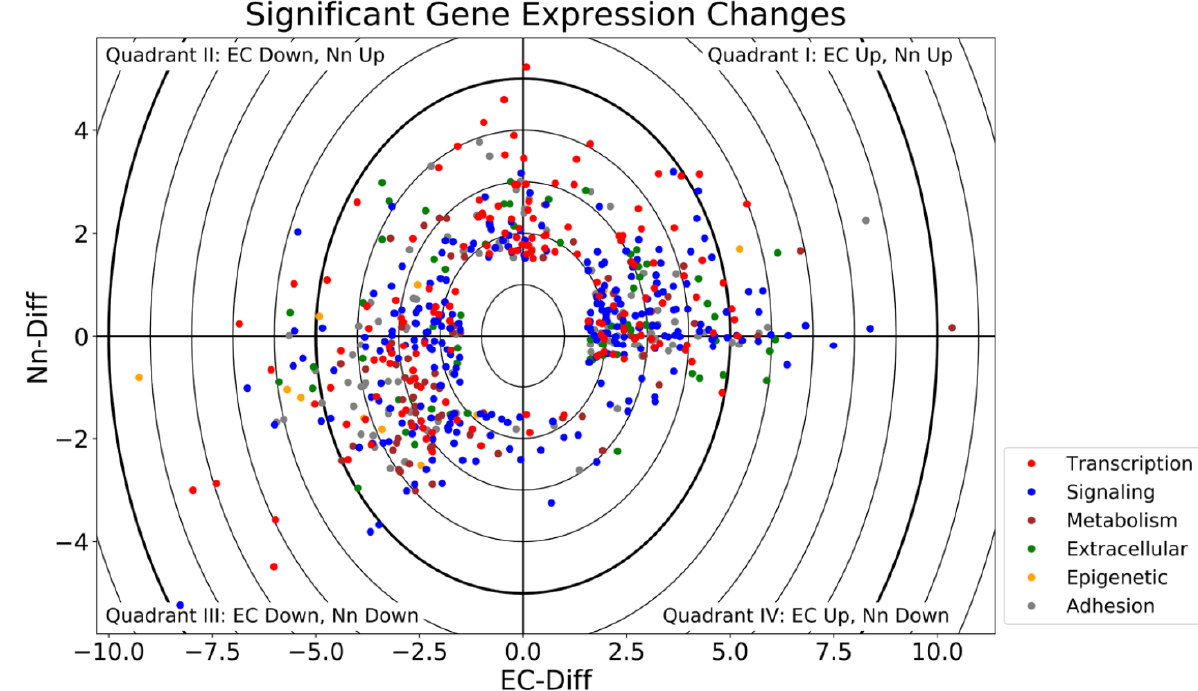
Figure 1. Schematic representation of the differentially expressed genes. Each quadrant represents genes that were positively or negatively altered when HiPS were differentiated towards neural (Nn-Diff) or endothelial (EC-Diff) cell phenotypes. Quadrant I (top right) upregulated in EC-Diff and Nn-Diff. Quadrant II (top left) downregulated in EC-Diff, upregulated in Nn-Diff. Quadrant III (bottom left) downregulated in EC-Diff and Nn-Diff. Quadrant IV (bottom right) upregulated in EC-Diff, downregulated in Nn-Diff. Colors correspond with the gene’s functional classification.